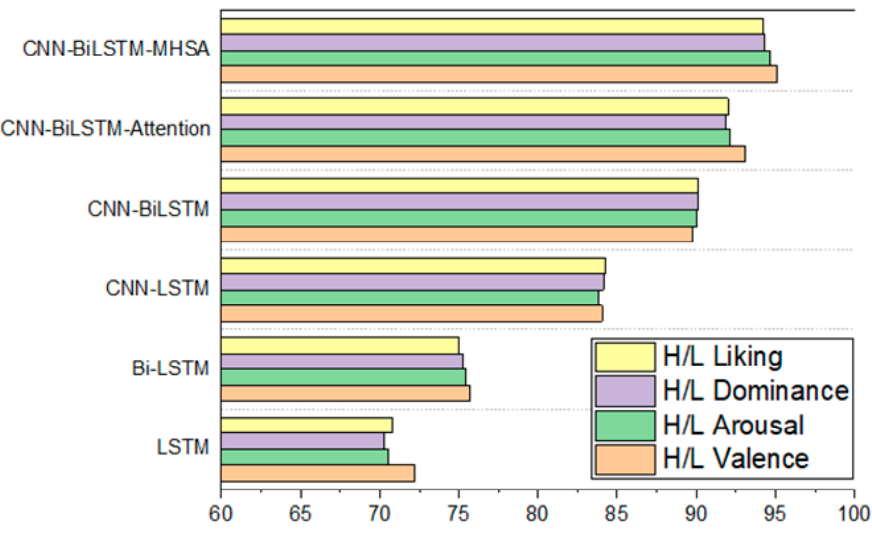
Figure 11. Model comparison chart.